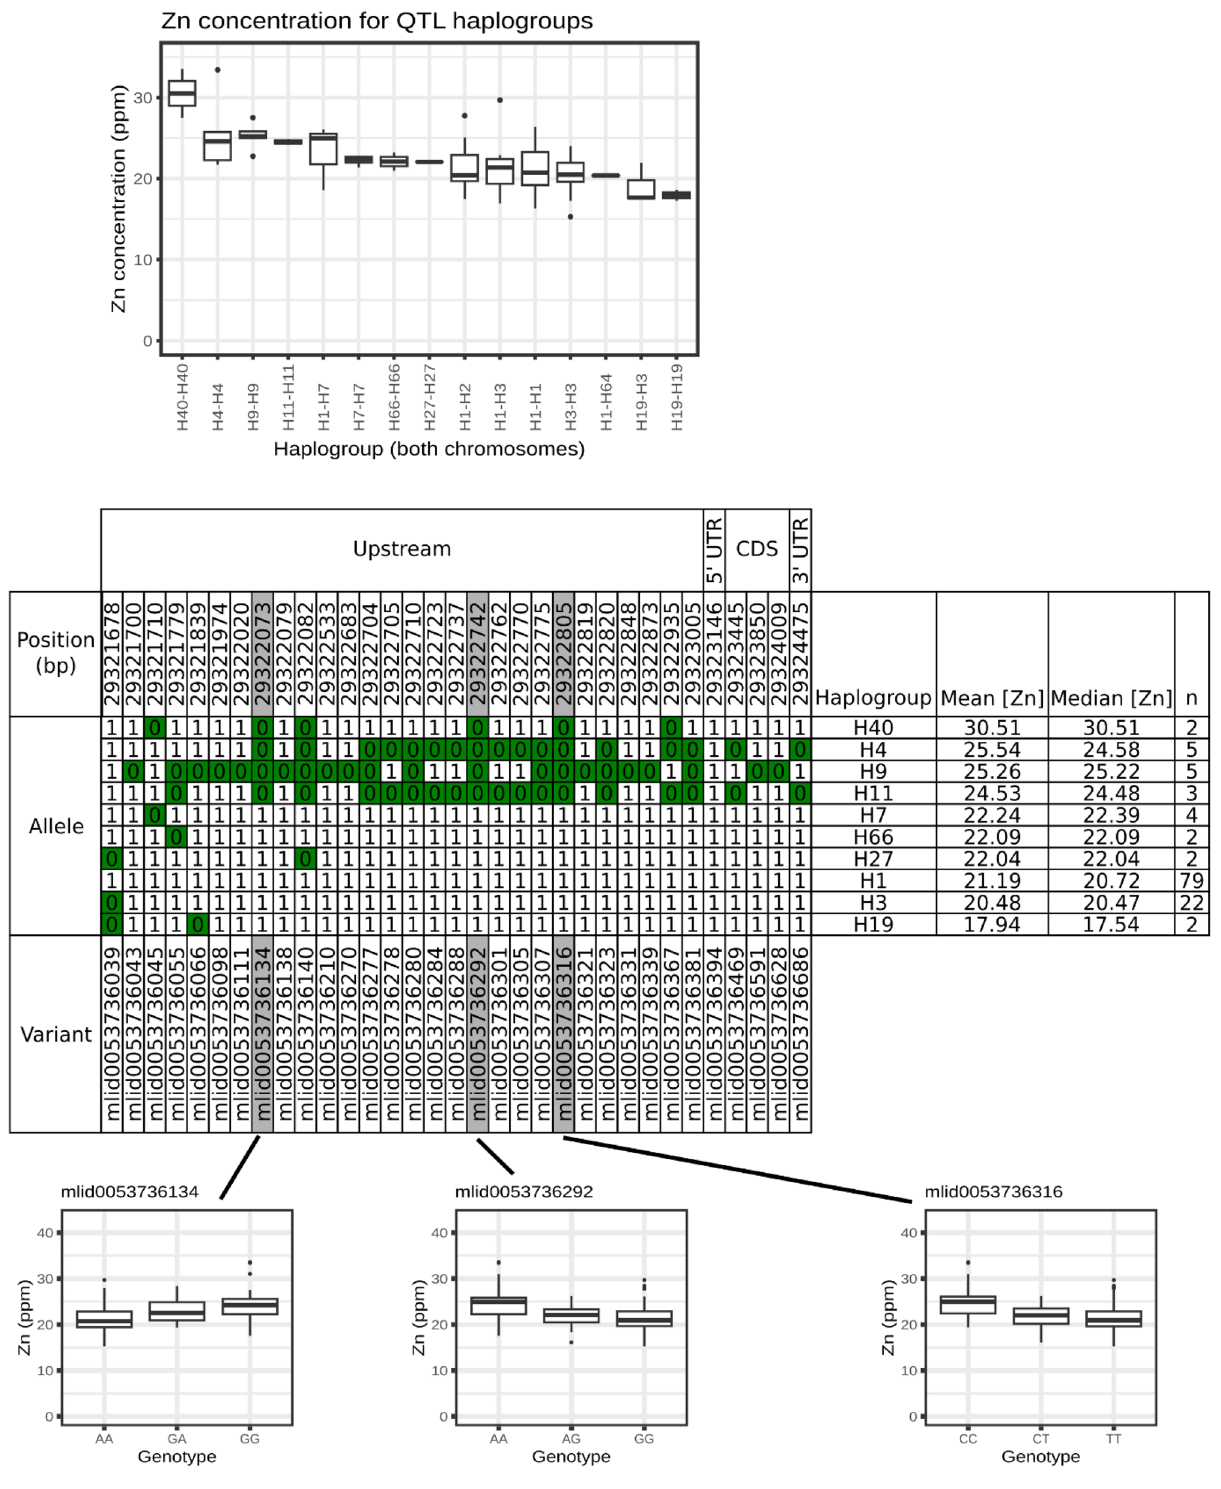
Figure 4. Haplotype analysis of OsNAS3 (a candidate gene under four- environment Zn QTL qZn7.2 , including 1.5 kb upstream from start codon. Top: boxplot of grain zinc concentration associated with each haplotype. Middle: SNP analysis of the same region for homozygous haplotypes, ordered by mean grain zinc concentration. Zero and one indicate allele status at each position. Asterisks indicate alleles found exclusively in the top four Zn haplotypes. Bottom: boxplots showing grain Zn concentration associated with each genotype for SNPs unique to high Zn